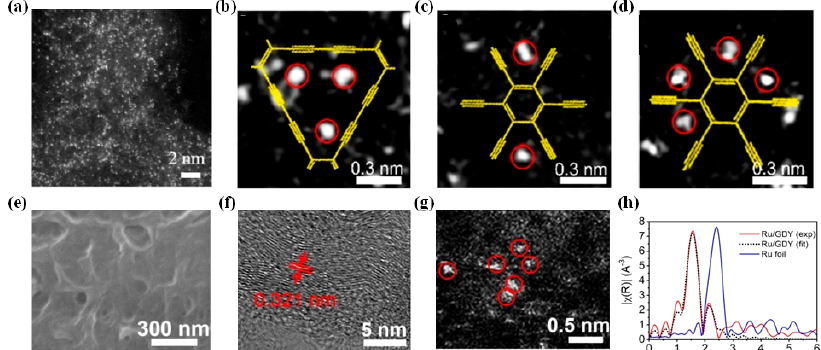
Figure 3. Structural characterizations of metal-atom-anchored GDY. ( a ) Atomic-resolution high-angle annular dark-field scanning transmission electron microscopy (HAADF-STEM) image for Pt-GDY (reproduced with permission from [62] . Copyright Wiley-VCH, 2018); ( b – d ) different configurations of the individual Mo-atoms anchored on the GDY structure (reproduced with permission from [63] . Copyright American Chemical Society, 2018); ( e ) scanning electron microscopy (SEM), ( f ) High-resolution transmission electron microscopy (HRTEM) and ( g ) HAADF images of Ru/GDY; ( h ) Experimental and fitted EXAFS spectra of Ru/GDY and Ru foil (reproduced with permission from [64] . Copyright Elsevier, 2020).